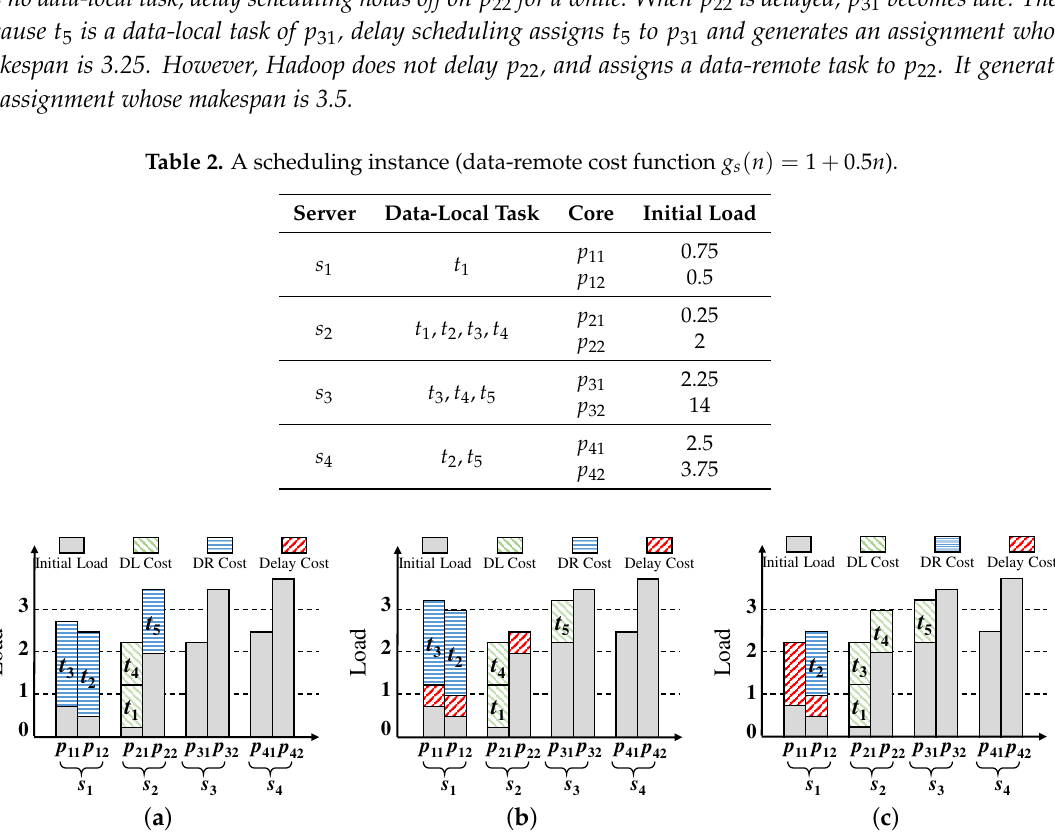
Figure 2. Assignment strategies of three online scheduling algorithms (DL indicates “data-local” and DR indicates “data-remote”). ( a ) Hadoop’s assignment, makespan = 3.5; ( b ) Delay scheduling’s assignment, makespan = 3.25; ( c ) DynDLOn’s assignment, makespan =